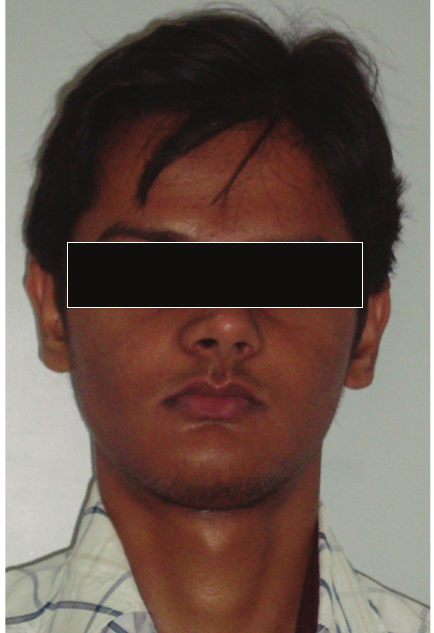
Figure 1: Extraoral photograph of patient (Case 1).